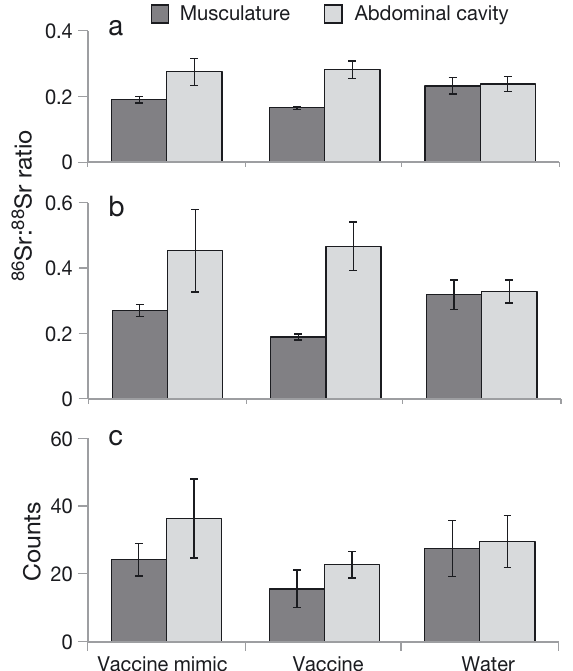
Fig. 5. Salmo salar . Strength of mark uptake with 86 Sr en- richment. Bar graphs show: (a) average ratio, (b) maximum ratio for scans above detection limit, and (c) number of scans above detection limit. Error bars represent ±1